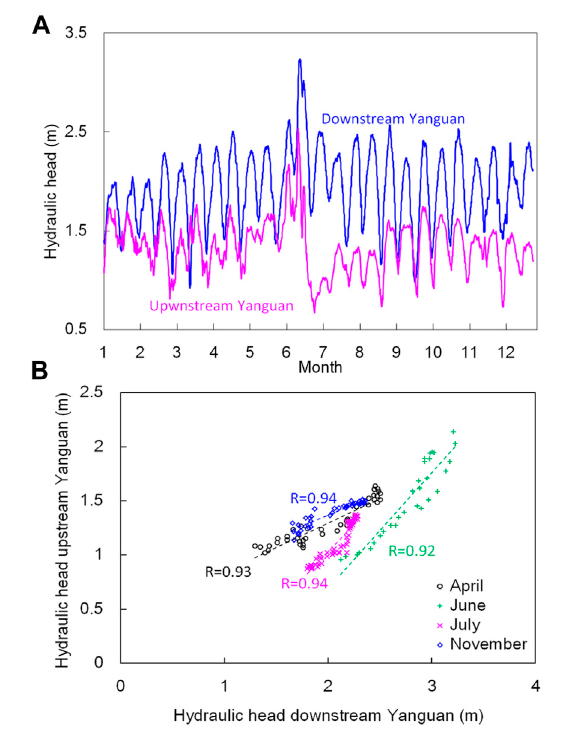
FIGURE 9 | Time series of the hydraulic heads over the upper and lower reaches (A) , and their relationships (B) .